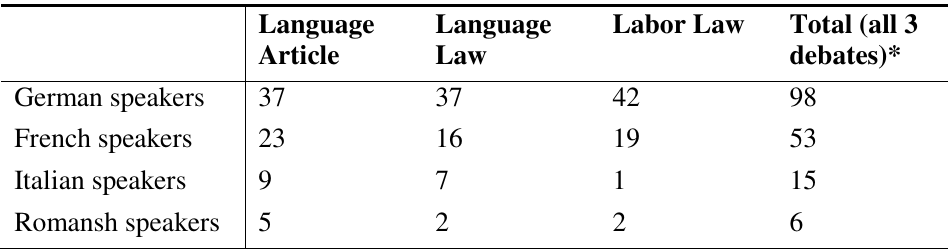
Table 7: Speakers